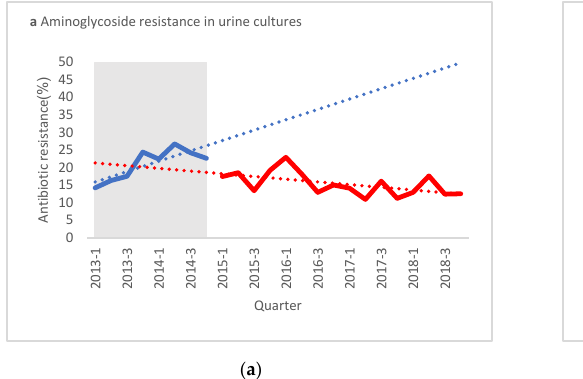
b Aminoglycoside resistance in blood cultures